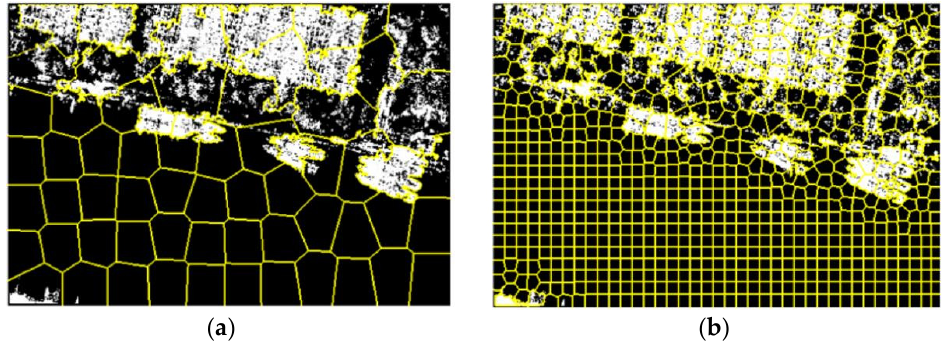
Figure 7. Segmentation effect under different k-values: ( a ) Splitting effect picture when K = 100; ( b ) Splitting effect picture when K = 1000.